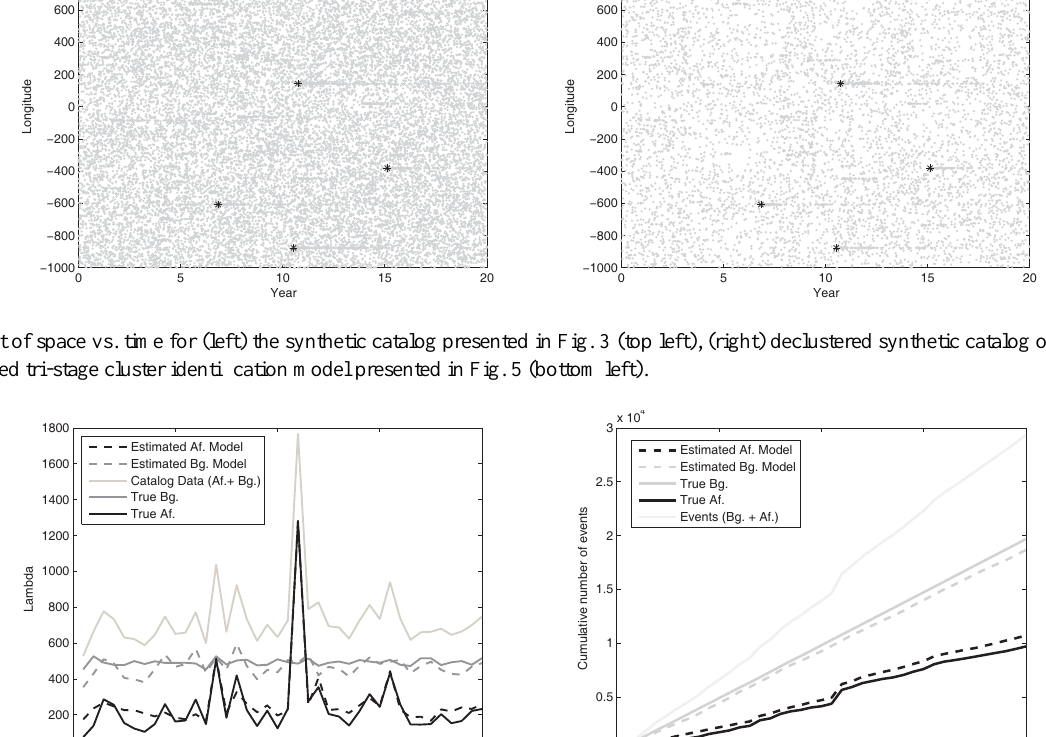
Fig. 7. Tri-stage cluster identification model result analysis for the synthetic catalog: (left) plot of Lambda values, (right) cumulative plot of events characterized as true aftershock and background for the synthetic catalog and estimated tri-stage model outputs. The plot of the lambda ( λ = Number of events/year) for the synthetic catalog is shown as the solid light-gray line in Fig.7 Table 3. List of parameters used to acquire the California, Japan and Indonesian Catalogs, ANSS (ANSS, 2012)